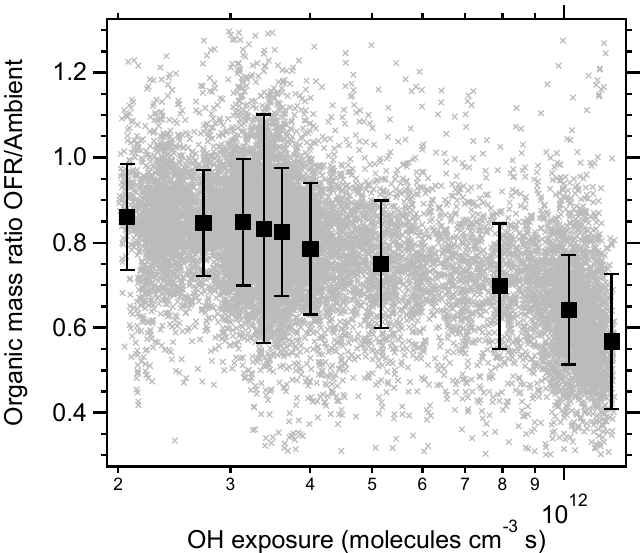
Figure 2. Aerosol mass spectrometer (AMS) mass peak di ff erence between reactor and ambient measurements as a function of nitrate equivalent mass (signal strength). Losses due to di ff usion or impaction would result in a linear decrease (given uniform particle composition). The dashed line shows the correlation between loss and signal excluding the fragments m / z 44, 28 and 18 (all belonging to the ion CO 2 + ) which shows a deviation consistent with evaporation and / or oxidation.